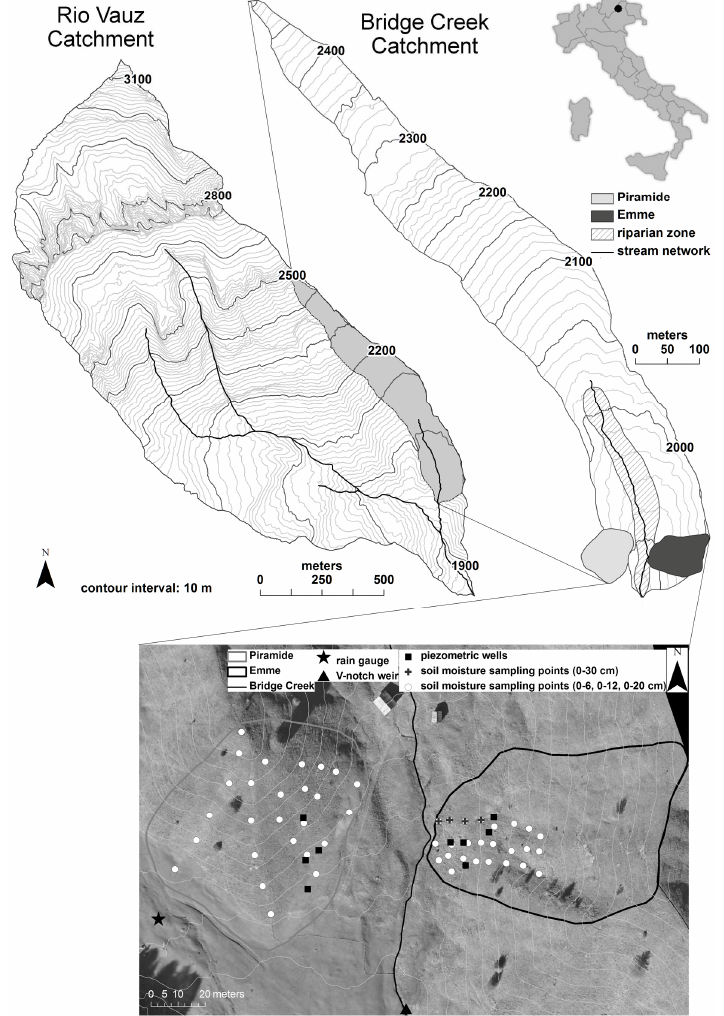
Figure 1. Location of the study area and field instrumentation. 651 Fig. 1. Location of the study area and field